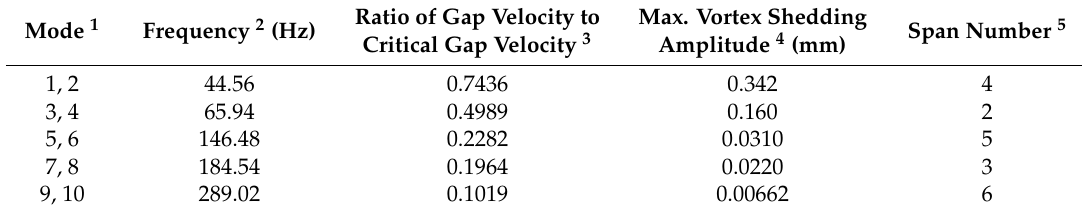
Table 12. Vibration analysis results after the additional support installation.